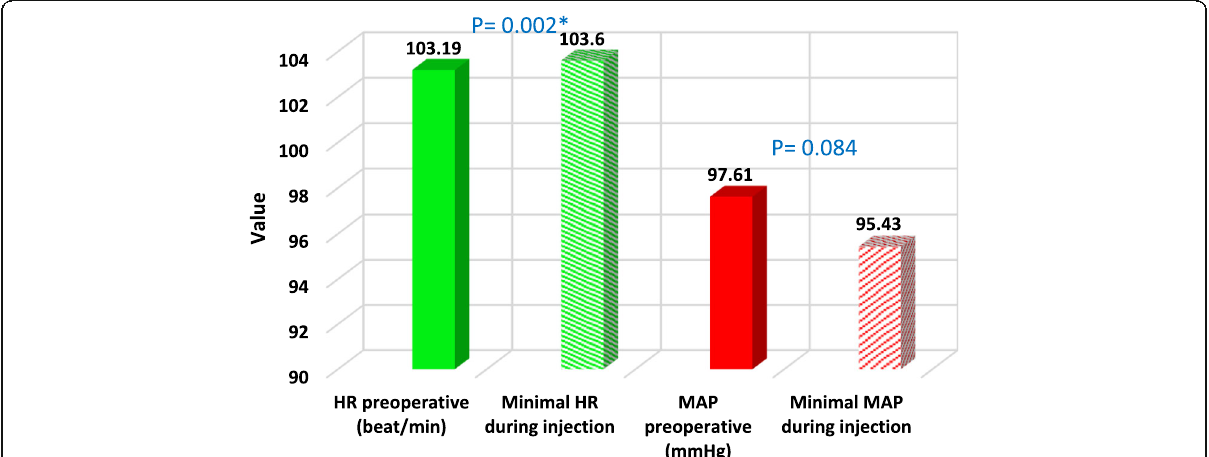
Fig. 4 The minimal mean values of heart rate (HR in beat/min) and mean blood pressure (MAP in mmHg) during spinal injection under PPS. Asterisks indicate significant difference compared to preoperative values, P ≤